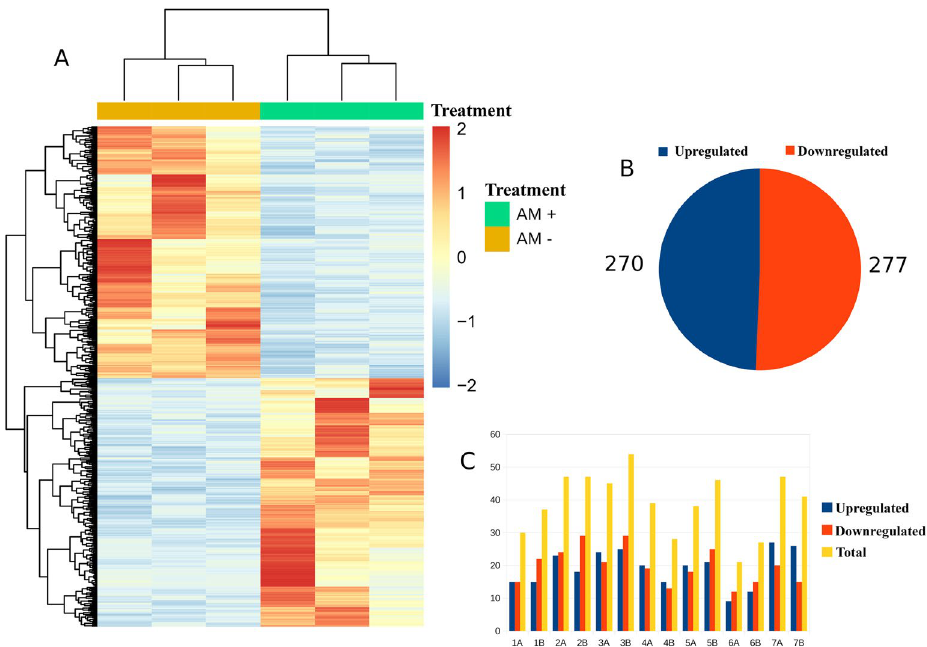
Figure 2. Overview of differential expression analysis performed with DESeq2. Heatmap of the normalized expression levels of the 563 Differentially Expressed Genes (DEGs) between the AM + and AM− conditions generated using the pheatmap R package (https:// cran.r- proje ct. org/ web/ packa ges/ pheat map/ index. html; version 1.0.12) ( A ). Number of Differentially expressed genes in the two conditions ( B ). Distribution of DEGs in the 7 chromosomes of the Triticum durum genome ( C